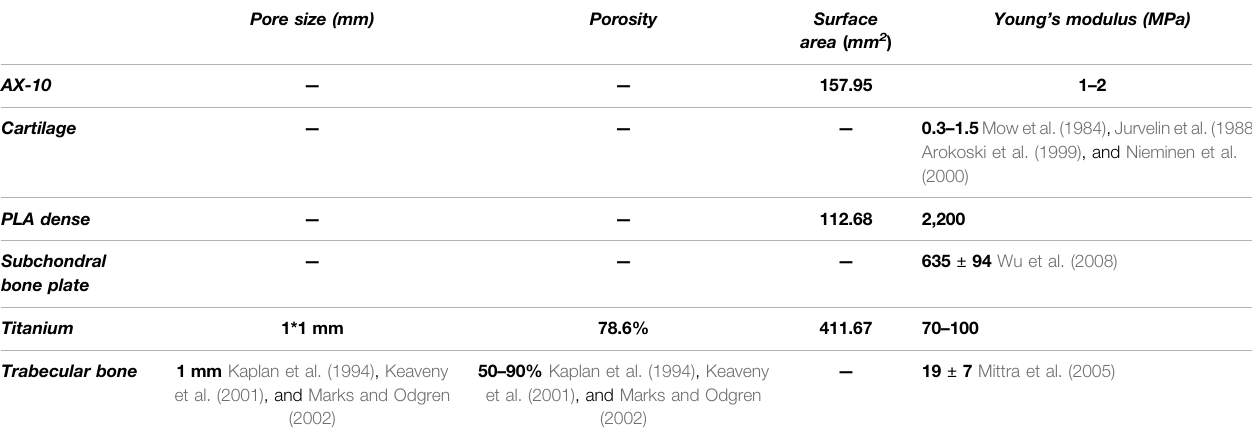
TABLE 1 | Characterization of the scaffold and bone.